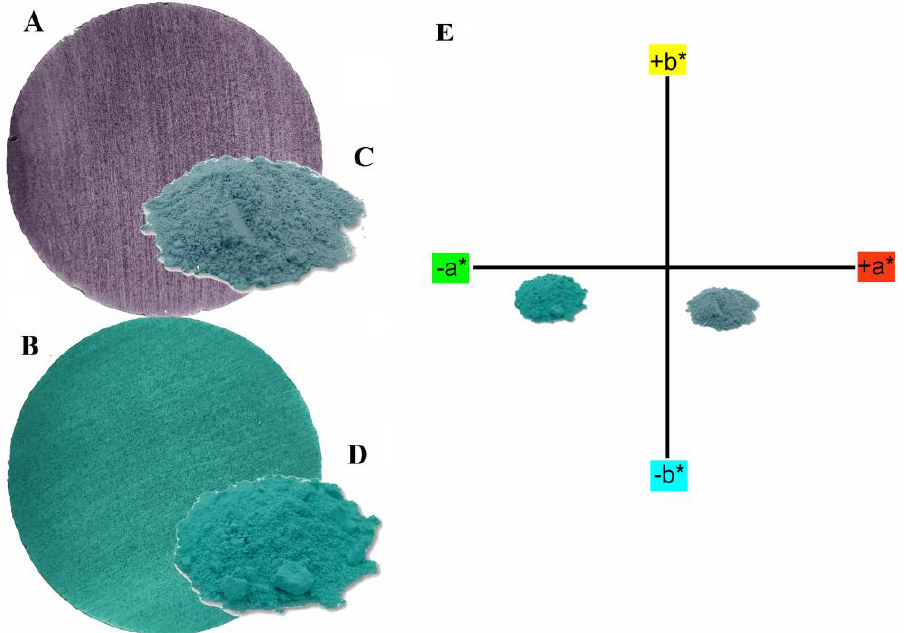
Figure 7. ( A ) specimen painted with pigment Co-abietate dispersed in acrylic paint; ( B ) specimen painted with pigment Cu-abietate dispersed in acrylic paint; ( C ) Co-abietate powder; ( D ) Cu- abietate powder; ( E ) colorimetric parameters a* and b* of the pigments in powder according to CIE L*a*b*.